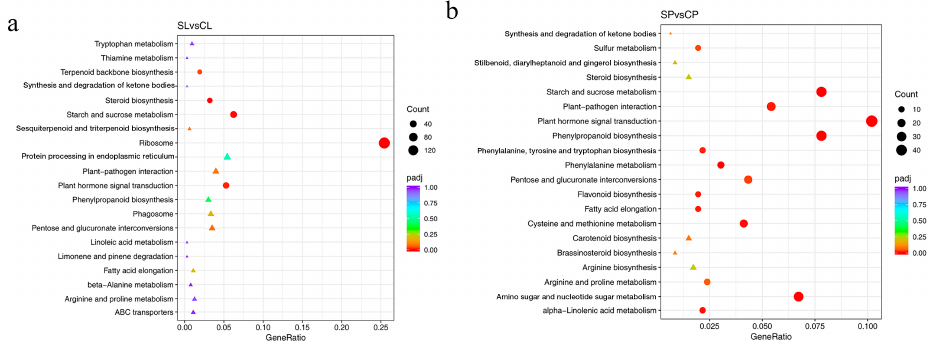
Figure 7. Enriched KEGG pathways based on DEGs identified in leaves and petioles under salt treatment. ( a ) Enriched KEGG pathways in leaves. ( b ) Enriched KEGG pathways in petioles. padj, adjusted p -value. Pathways that have a p -value under a threshold of 0.05 were identified as significantly enriched pathways, and marked with a circle. Pathways in a triangle have a p -value above 0.05.